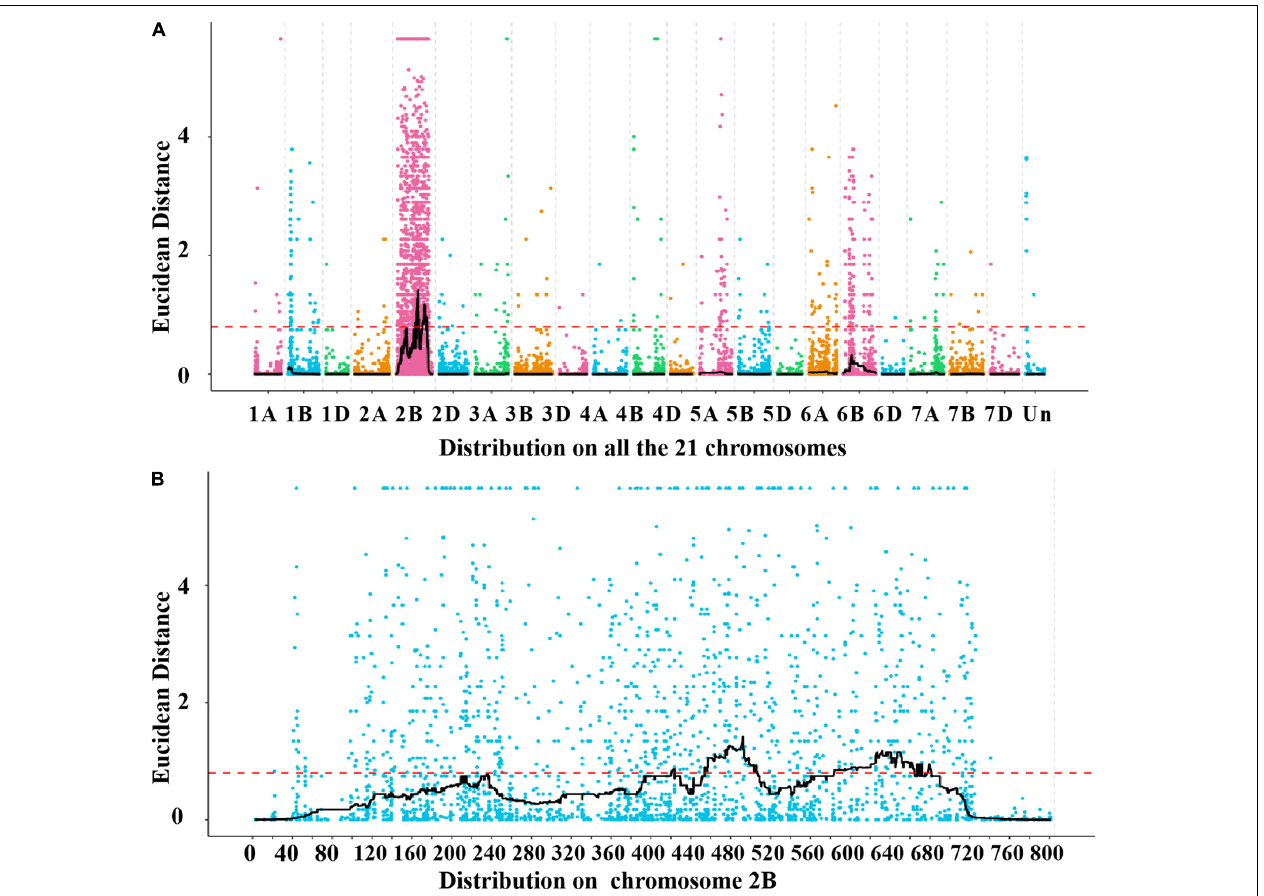
FIGURE 3 | Distribution of the SNPs with consistent differences between the resistant parent YD588 and susceptible parent YN21 and their derived bulked pools on 21 chromosomes (A) and on the chromosome arm 2B (B) based on the Euclidean distance (ED) algorithm.